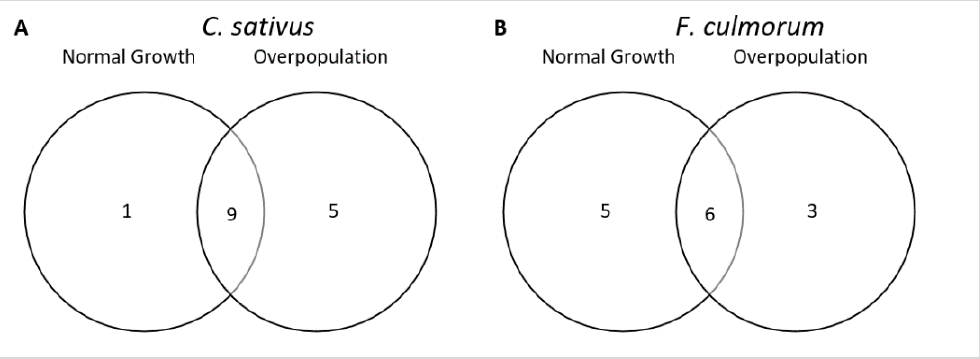
Figure 5. Grouping the specific VOCs emitted by each species in the normal and overpopulation growth conditions. ( A ) VOCs emitted by C. sativus ( B ) VOCs emitted by F. culmorum .